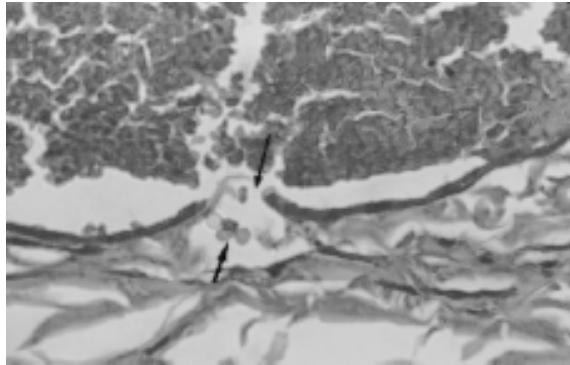
FIGURA 5 - Fotomicrografia mostrando detalhe da lesªo na parede vascular com extravasamento de cØlulas